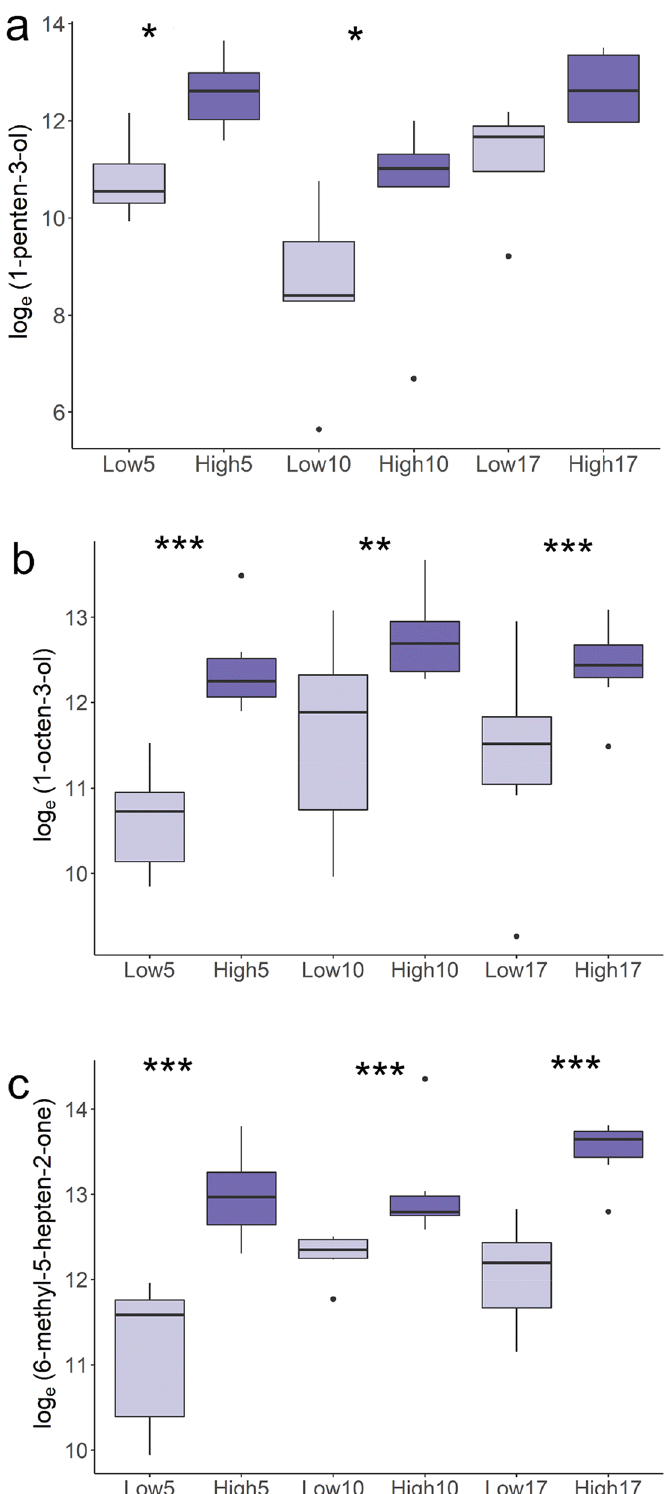
Figure 1. Boxplot and whisker plot showing differential expression (Loge to GC peak area) of 1-penten-3-ol ( a ), 1-octen-3-ol ( b ) and 6-methyl-5-hepten-2-one ( c ) across salmon with high and low lice count (High, Low) across culture temperatures (5, 10 and 17 °C), n = 4 per group, significance level after Benjamini–Hochberg correction (*p < 0.05; **p < 0.01; ***p < 0.001). Median is given as solid line, box is the interquartile range and whiskers are 1.5 times the interquartile